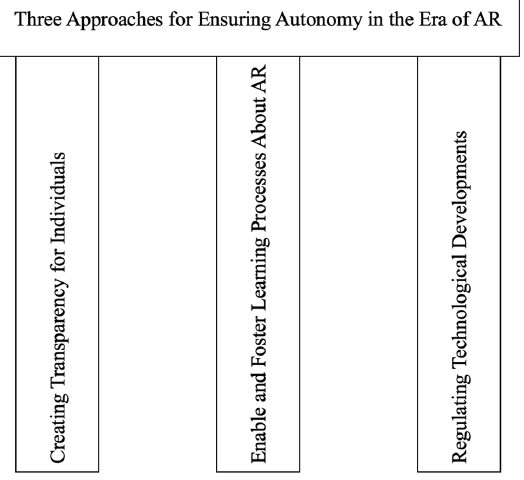
Figure 1. Three approaches for ensuring autonomy in the era of